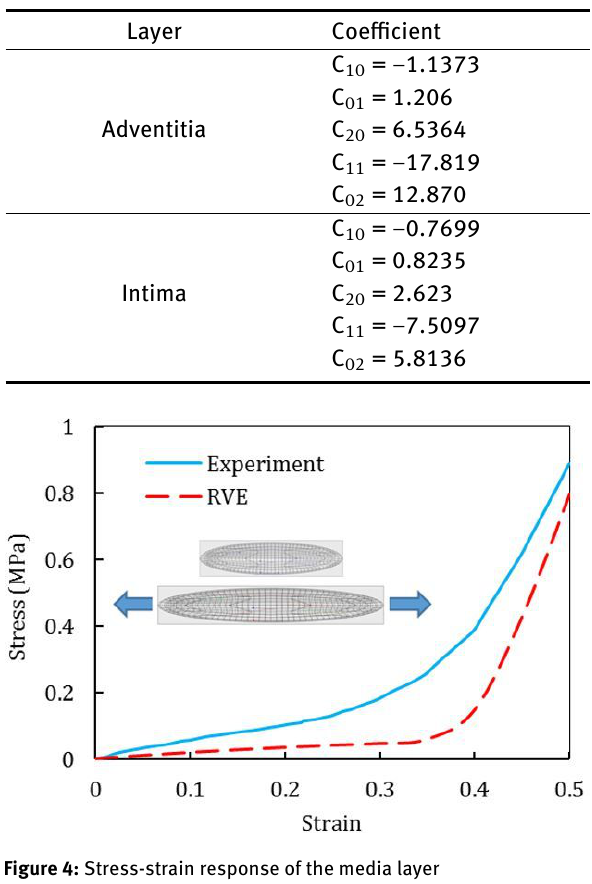
Table 4: Material coeflcients of both adventitia and intima layers